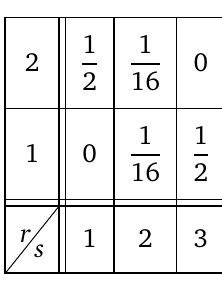
Table 2.1: Kac table of the first minimal unitary model of CFT, corresponding to the Ising model. Irreducible representation of the Virasoro algebra are labeled by indices r = 1,2 and s =